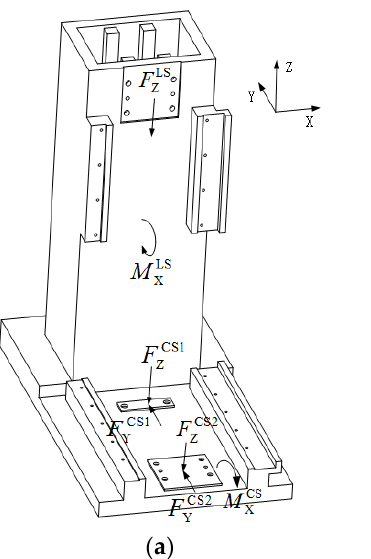
Table 2. Static deformation and stress of separate structure.